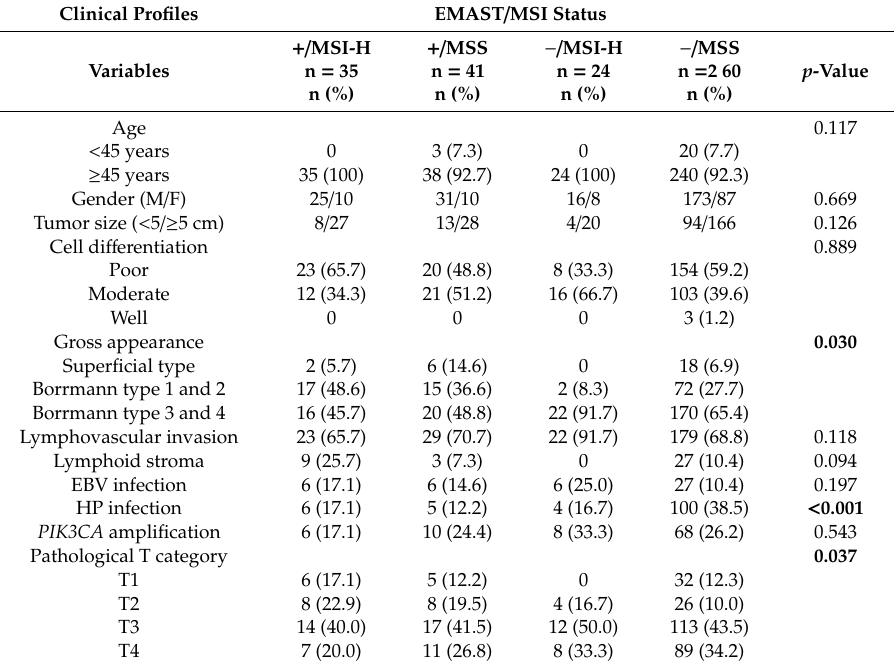
Table 2. Clinical profiles among patients according to the EMAST / MSI